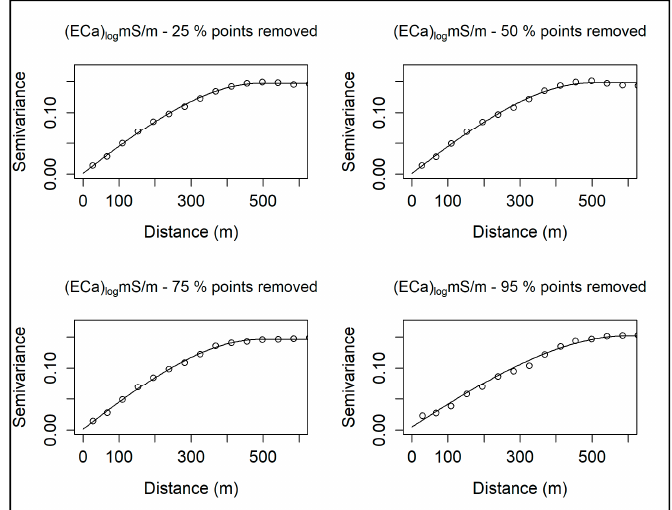
Figure 9. Empirical (circles) and adjusted (lines) semivariogram models for natural logarithm transformations of different soil ECa sample density reductions (i.e., 25%, 50%, 75%, and 95%), using the Douglas-Peucker algorithm.